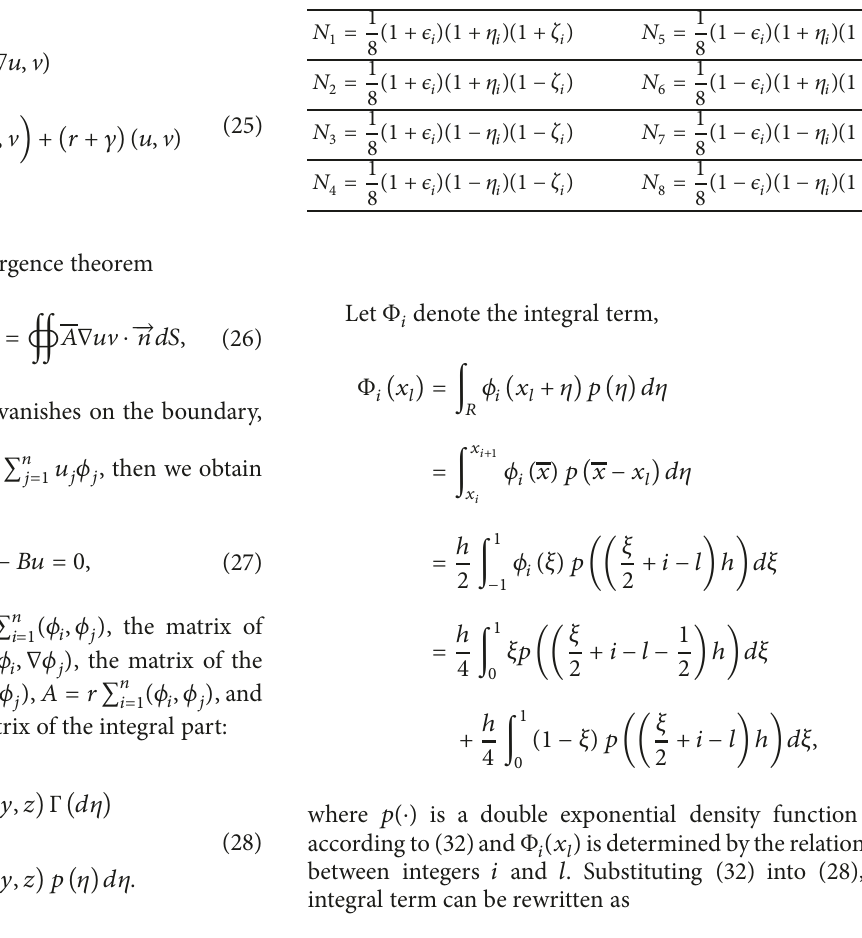
Table 1: 8-node hexahedral